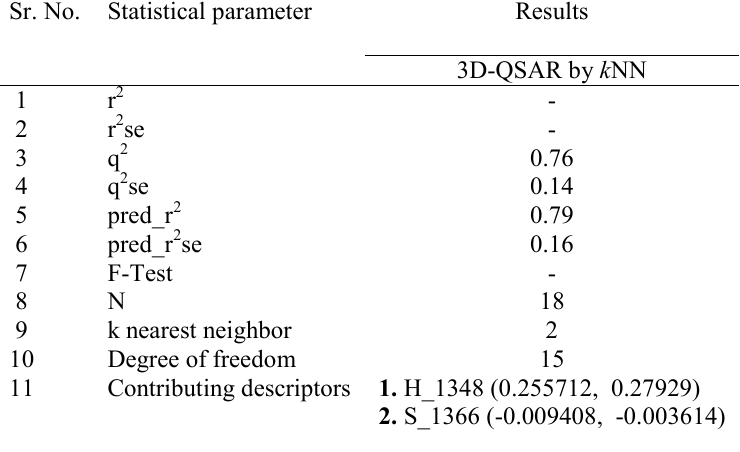
Table 3. Statistical results of 3D-QSAR model generated by forward stepwise variable selection k NN MFA method for indol-2-yl ethanones derivatives.